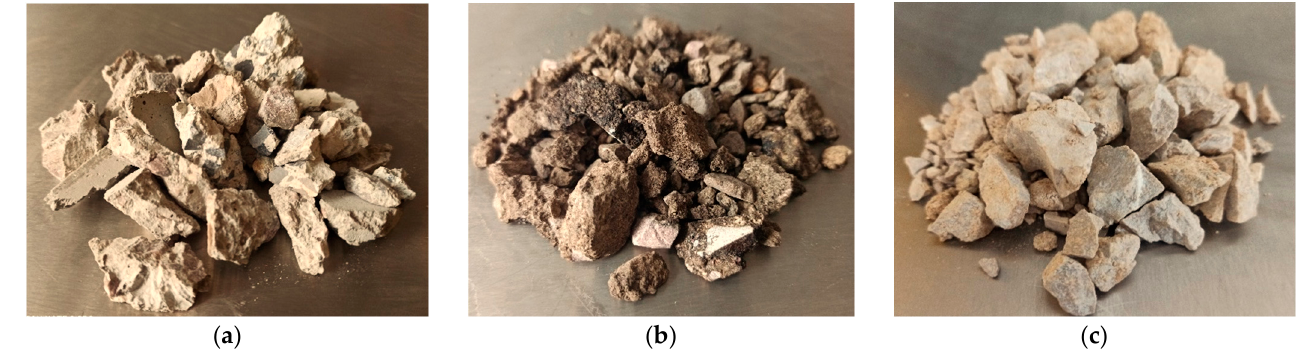
Figure 1. Reclaimed materials comprising the cold-recycled mixtures with foamed bitumen: ( a ) re- claimed cement material; ( b ) reclaimed asphalt pavement (RAP); ( c ) reclaimed aggregate (RA).